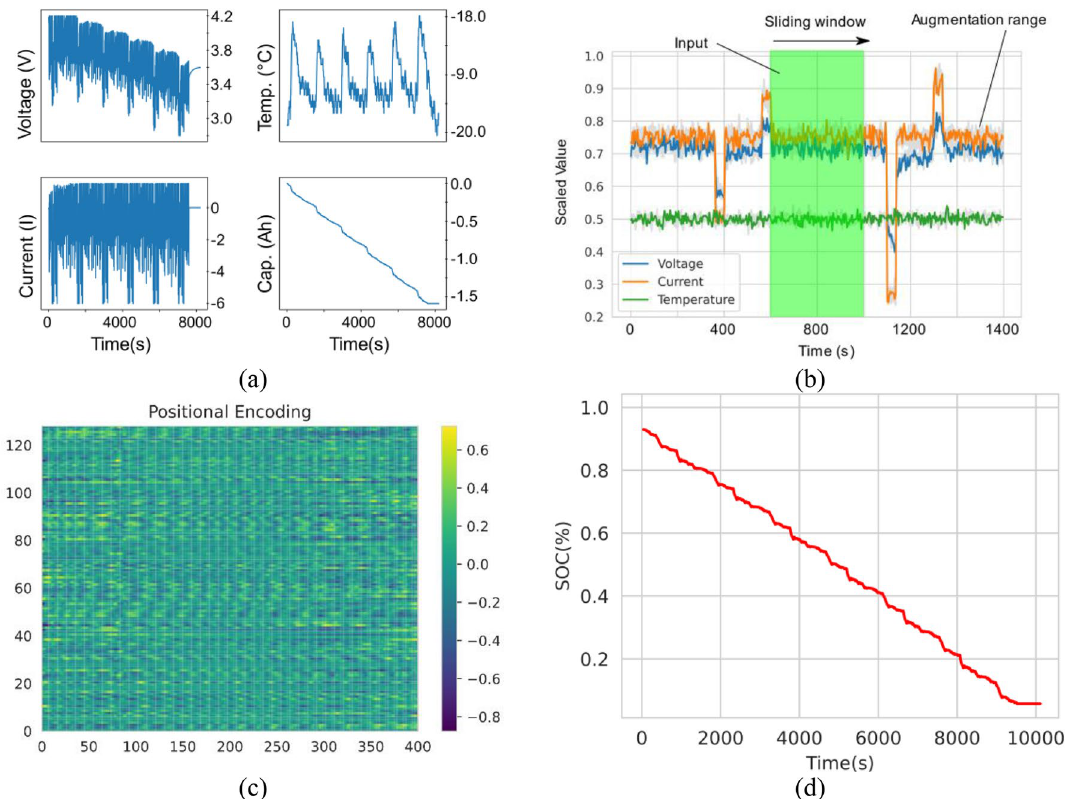
Figure 5. Data preprocessing pipeline from raw values to positional encoding. ( a ) Raw data sample plot from the UDDS drive cycle at − 20 °C ambient temperature. ( b ) Input-label pairs constructed by sliding a fix width window across the train, validation, and test dataset. ( c ) Dataset converted into positional encoding to be ingested into